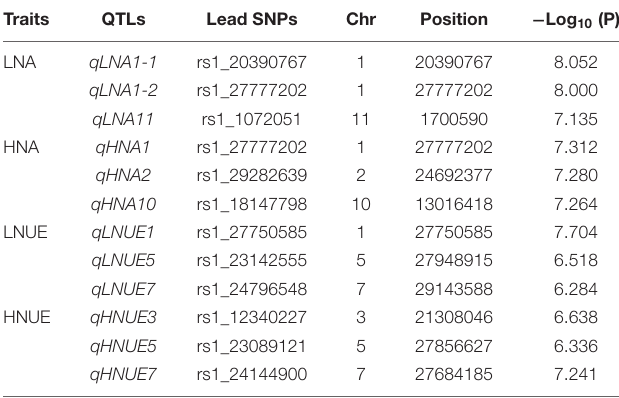
TABLE 1 | Lead SNPs for LNA, HNA, LNUE, and HNUE identified by GWAS. Traits